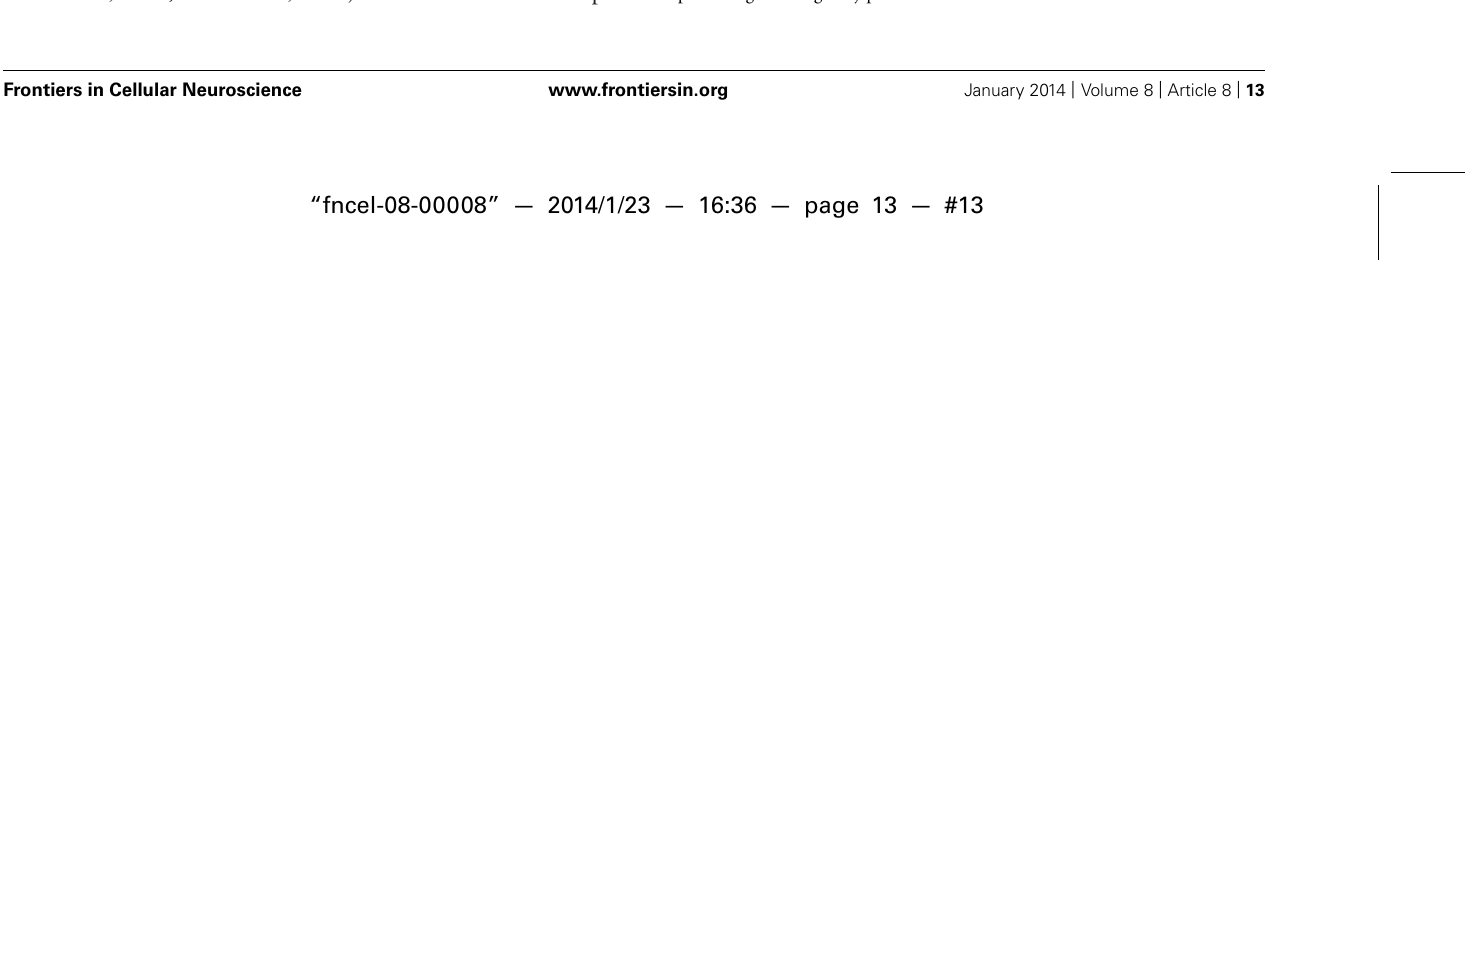
2010; Tasic et al., 2011) so that they are universally